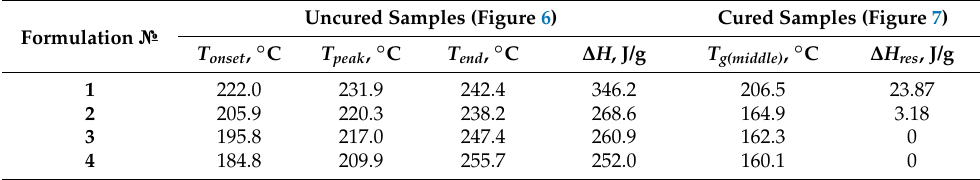
Figure 7. DSC curves of formulations 1–4 cure. Table 4. Characteristic temperatures of DSC curves of uncured and cured samples for formulations